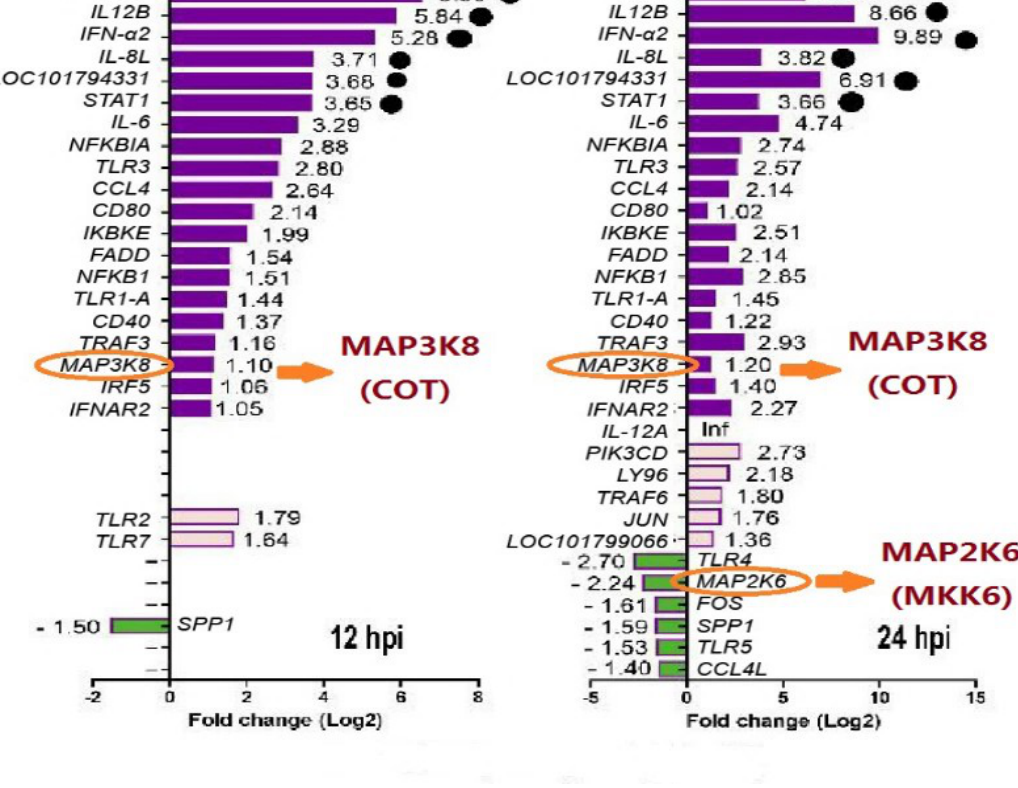
Figure 4. RNA-seq results of the Toll-like receptor (TLR) signaling pathway. Mitogen-activated protein kinase (MAP3K8) (COT) showed up-regulation of transcription levels after 12 h and 24 h infection of duck Tembusu virus (DTMUV), whereas MAP2K6 (MKK6) was down-regulated only after 24